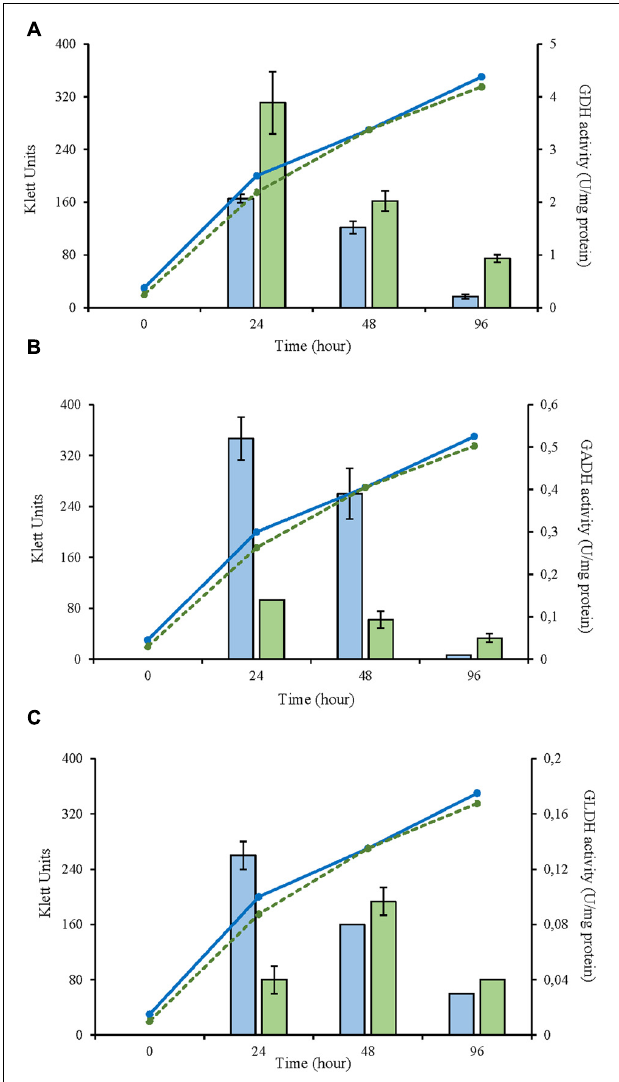
FIGURE 1 | Enzyme activity and growth (expressed in Klett units) of two Gluconobacter japonicus strains at three different growth stages (24, 48, and 96 h). (A) Glucose dehydrogenase activity (mGDH); (B) Gluconate dehydrogenase activity (GADH); (C) Glycerol dehydrogenase activity (GLDH). Enzyme activity represented in bars: NBRC 3271 ( (cid:4) ), CECT 8443 ( (cid:4) ) and cell growth with lines: NBRC 3271 ( ); CECT 8443 (